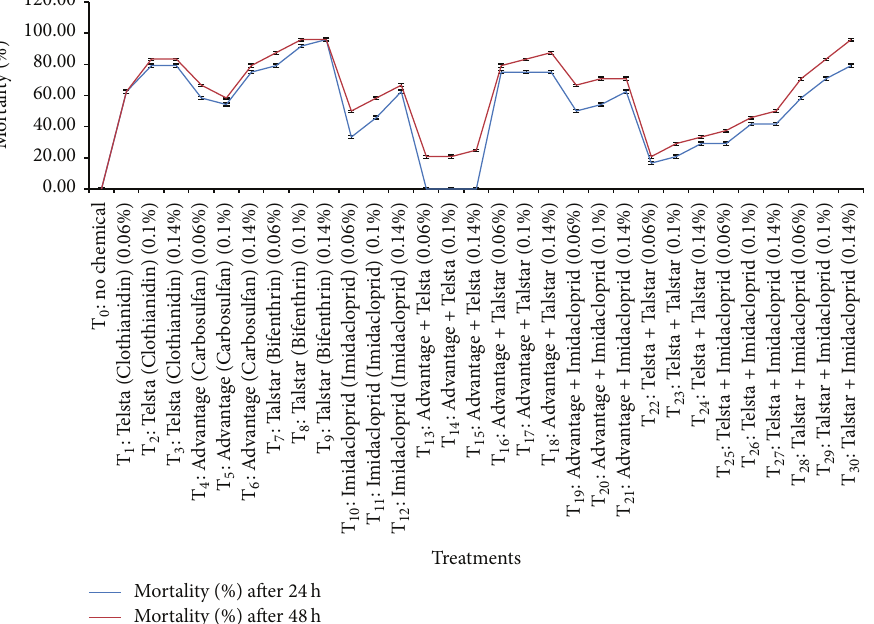
Figure 1: Mortality (%) of adult females of hibiscus mealybug after 24 and 48 h at different concentrations of insecticides in laboratory